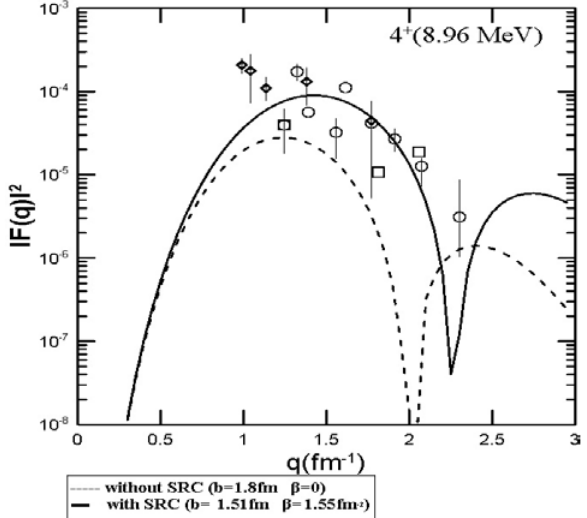
Fig. 7: Inelastic Coulomb 4 C form factors for the transition to the 14 + (8.96 MeV) state. The dashed and solid curves are the calculated 4 C form factors without and with the inclusion of the effect of the SRC, respectively. The open circle, open square and rhombic symbols are those of the experimental data taken from